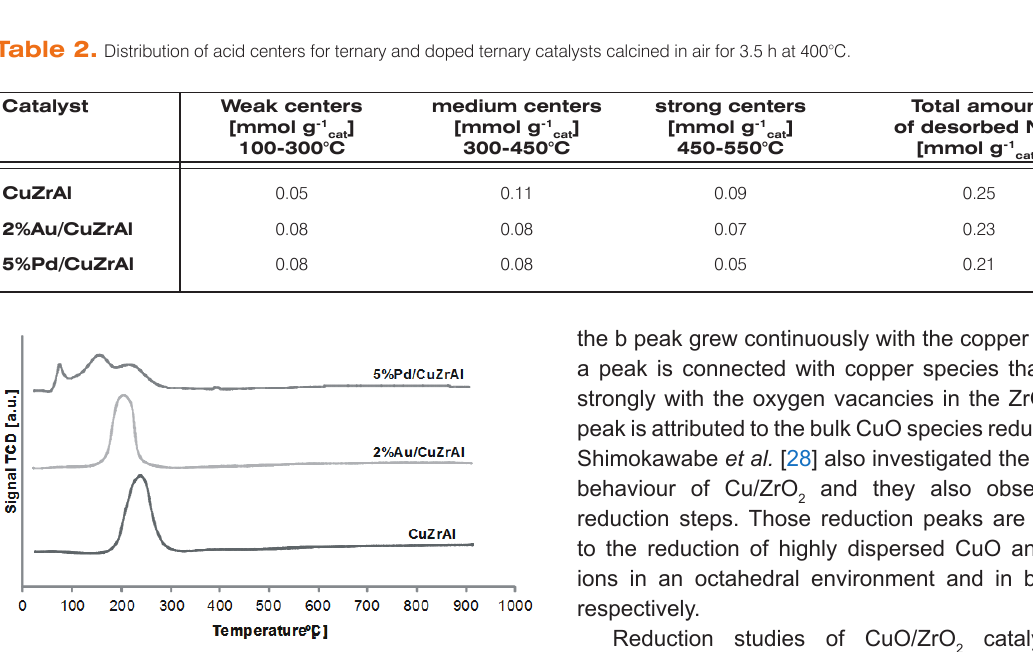
Figure 3. TPR of CuZrAl, 2%Au/CuZrAl and 5%Pd/CuZrAl catalysts after calcination in air at 400°C for 3.5 h.